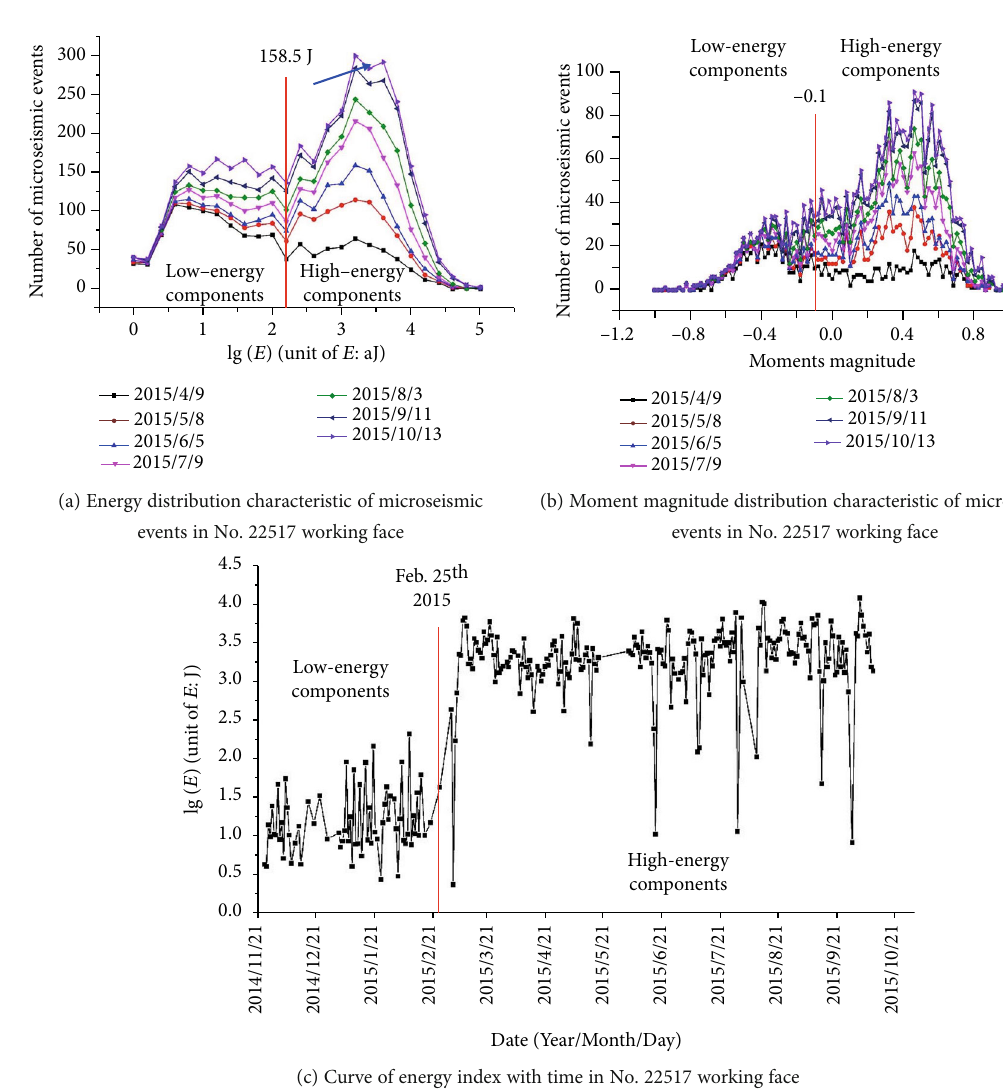
Figure 14: Energy and moment magnitude distribution of MS